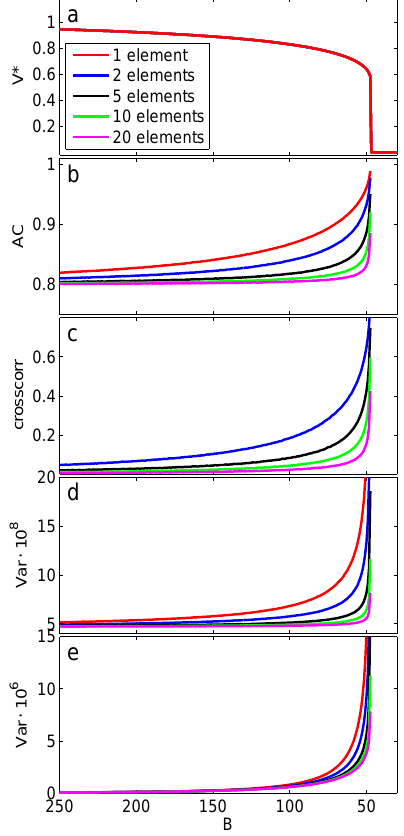
Fig. 3. Characteristics of system 2 in dependency on parameter B for versions with a different number of elements. (a) Equilibrium vegetation cover (identical for any number of elements), (b) auto- correlation (lag 1), (c) cross-correlation (no lag), (d) variance (addi- tive noise only), (e) variance (multiplicative noise only). Note that all elements of a specific system are identical and thus have the same measured